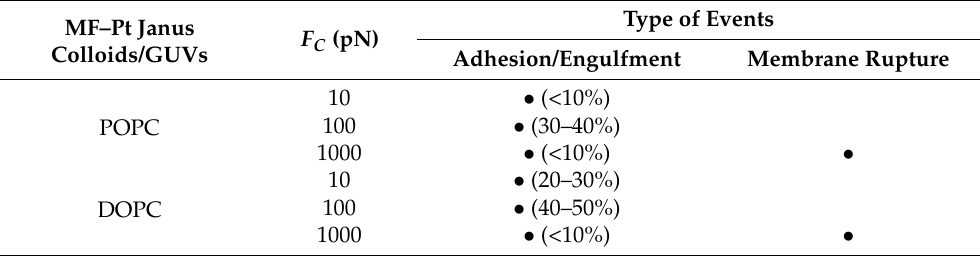
Table 1. Effect of centrifugal force on POPC and DOPC GUVs interacting with MF–Pt Janus colloids, where ( • ) signifies a significant number of observed